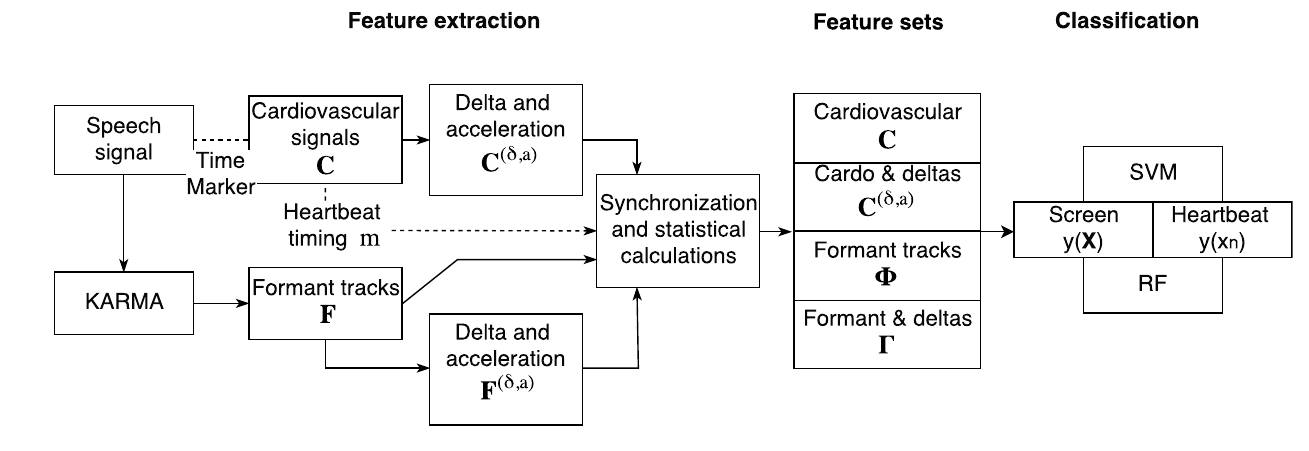
Figure 2. Overview of the feature extraction, feature synchronization and classification